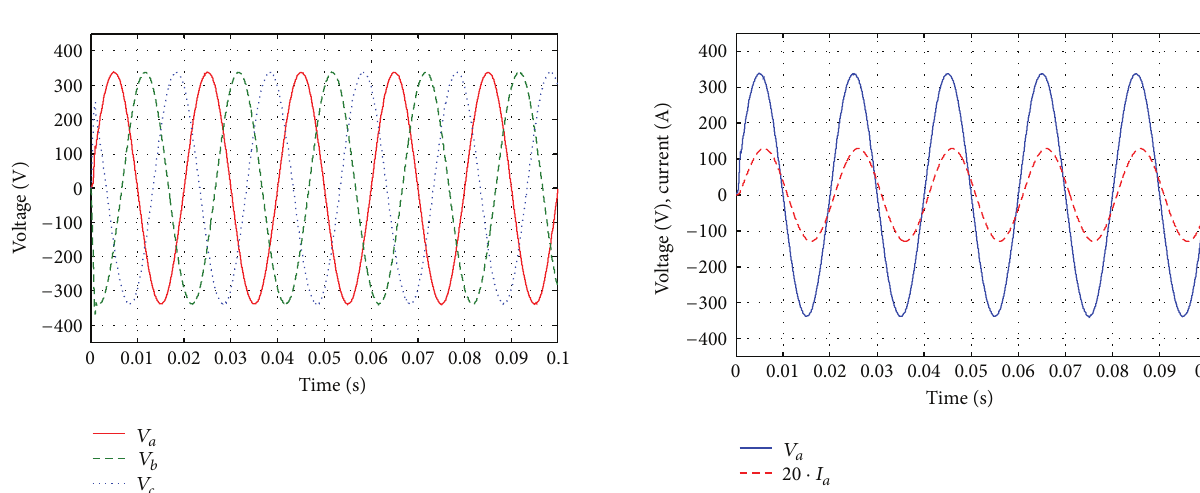
Figure 19: Output voltage (𝑉 𝑎 ) and current load (𝐼 𝑎 ) of the inverter with 𝑅𝐿 load.